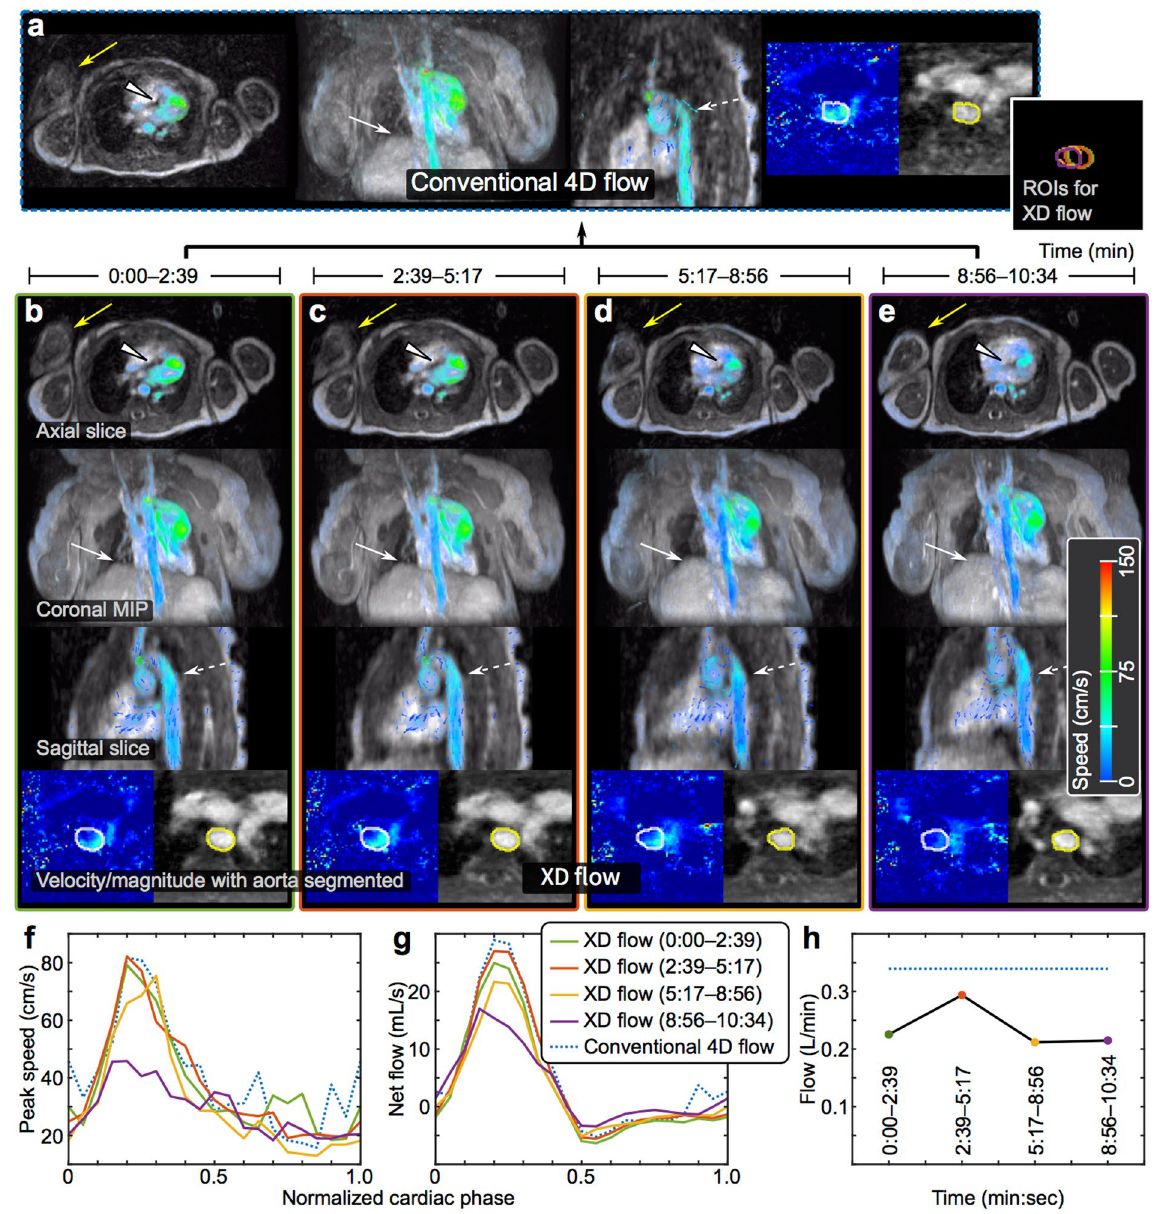
Figure 2. XD flow reconstruction of a 3-day-old female highlighting enhanced motion robustness. ( a ) Conventional 4D flow reconstruction for the 10:34 min acquisition. ( b – e ) The same dataset reconstructed into 4 shorter temporal windows — each window was 2:39 min. ( f ) Peak speed in aorta. ( g ) Net flow in aorta. ( h ) Average flow for each temporal window compared to conventional 4D flow (dotted blue). Different reformats of a single cardiac phase are shown: axial slice, coronal 50-cm MIP, sagittal slice, and velocity/magnitude of aorta with segmentation. The non-sedated patient with ferumoxytol enhancement was observed to be moving as noted by different positions of the right arm (yellow arrow). Also, the region-of-interests (ROIs) segmented for each temporal phase of XD flow are combined to emphasize the movement of the aorta (far right of ( a )). With motion corruption, the flow in the aorta is noisy with unrealizable flow vectors in the conventional 4D flow, but the flow is recovered in the XD flow reconstruction (dashed white). Similarly, the myocardial border (white triangle) and diaphragm (white arrow) are better depicted in the XD flow reconstruction. The blood flow measured from XD flow varies over time; this effect is ignored in conventional 4D